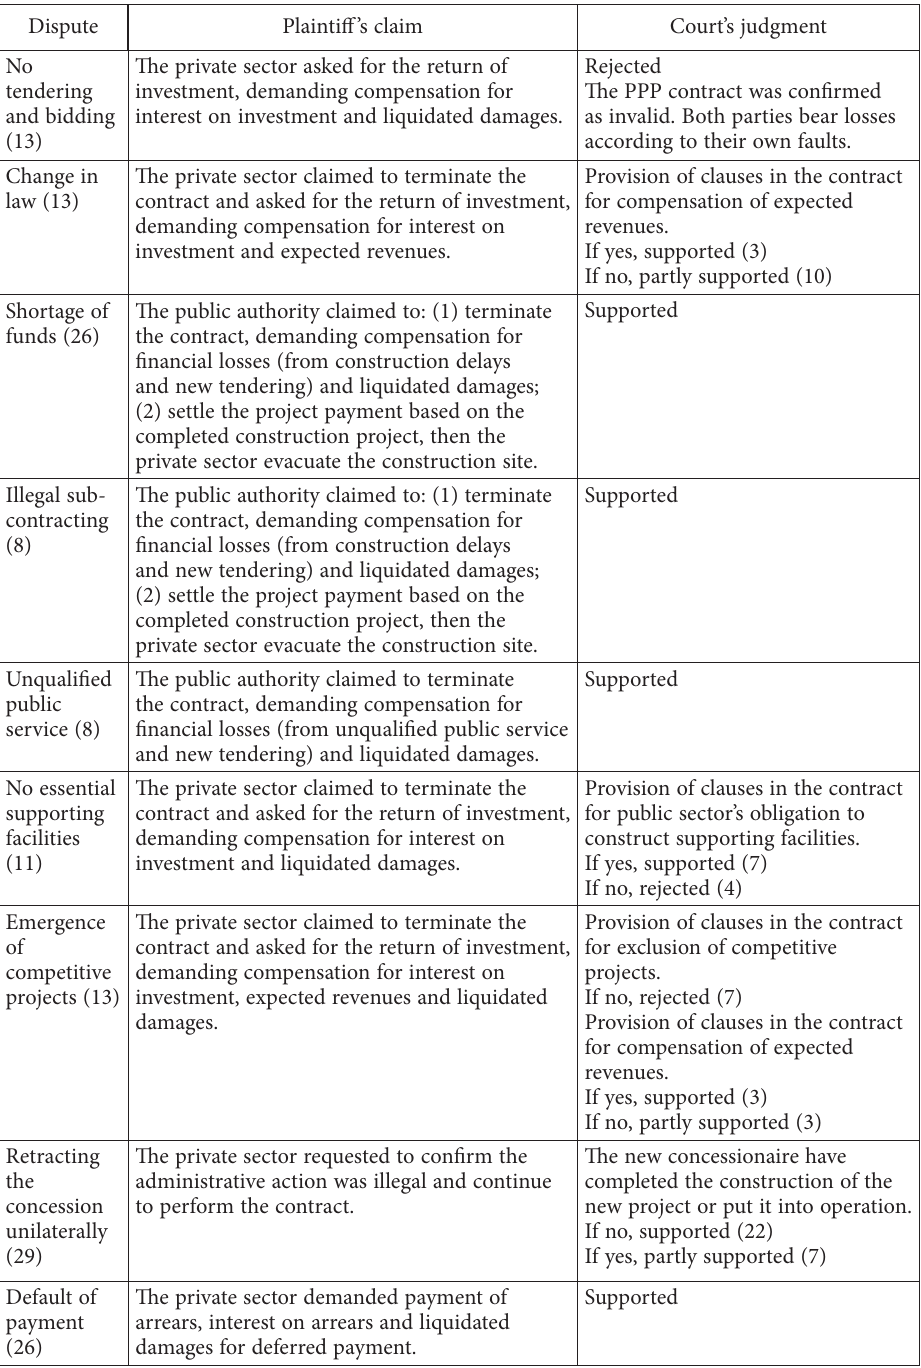
Table 4. Main results of